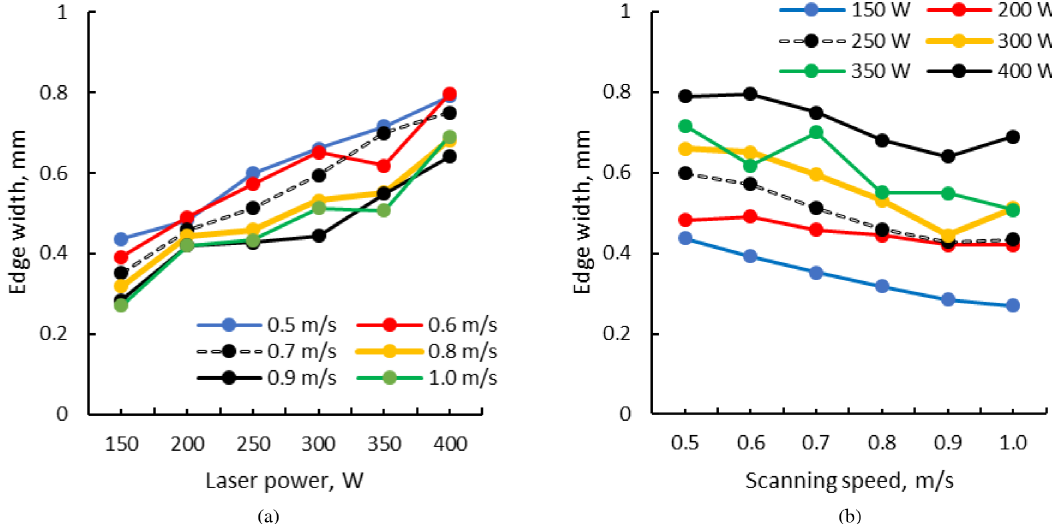
Fig. 7. Edge width as a function of laser power (a) and scanning speed (b).